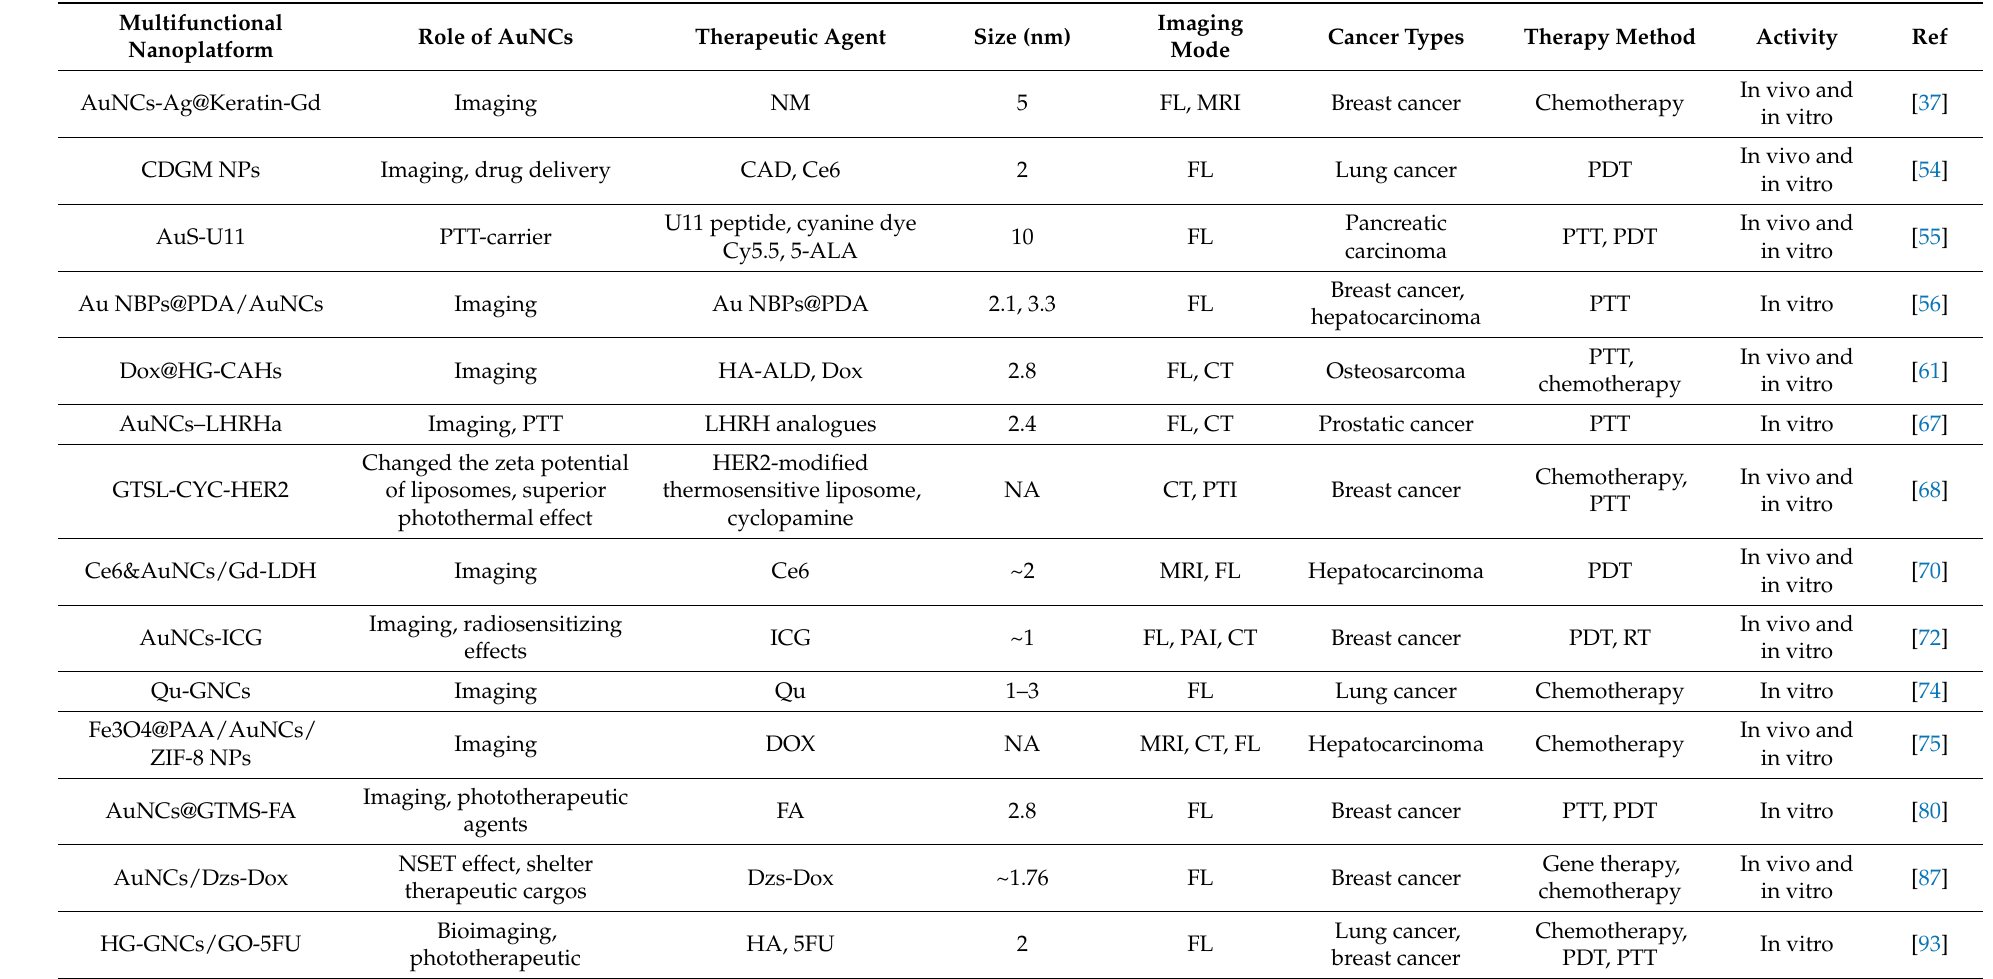
Table 1. Application of